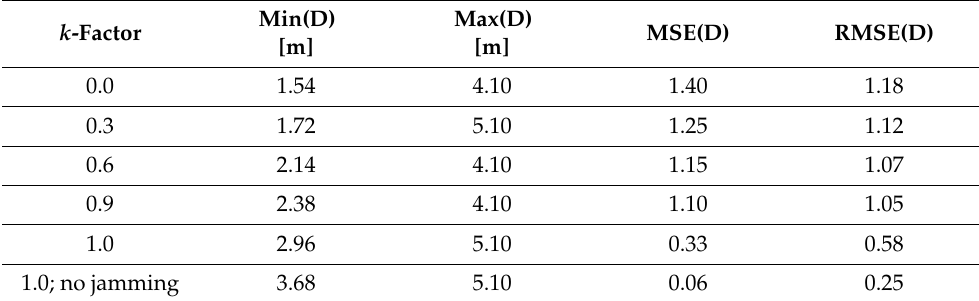
Table 1. Minimum and maximum estimated distance and mean square error for different k .